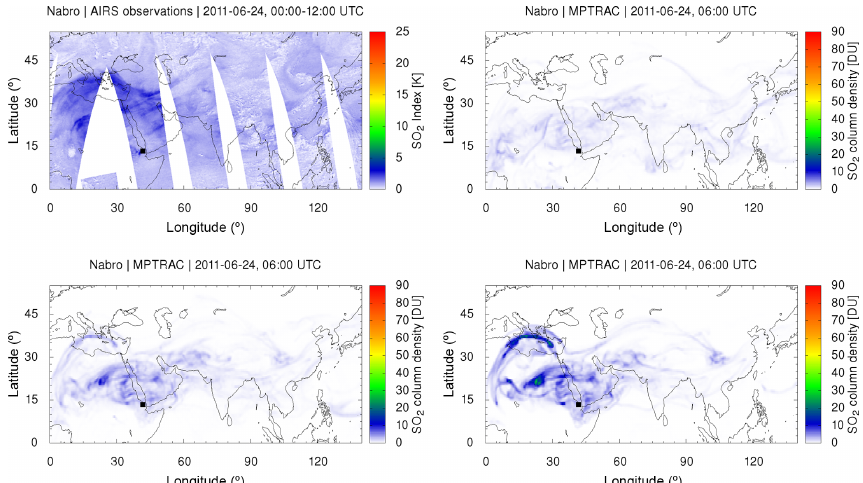
Figure 17. Same as Fig. 11, but for 24 June 2011,